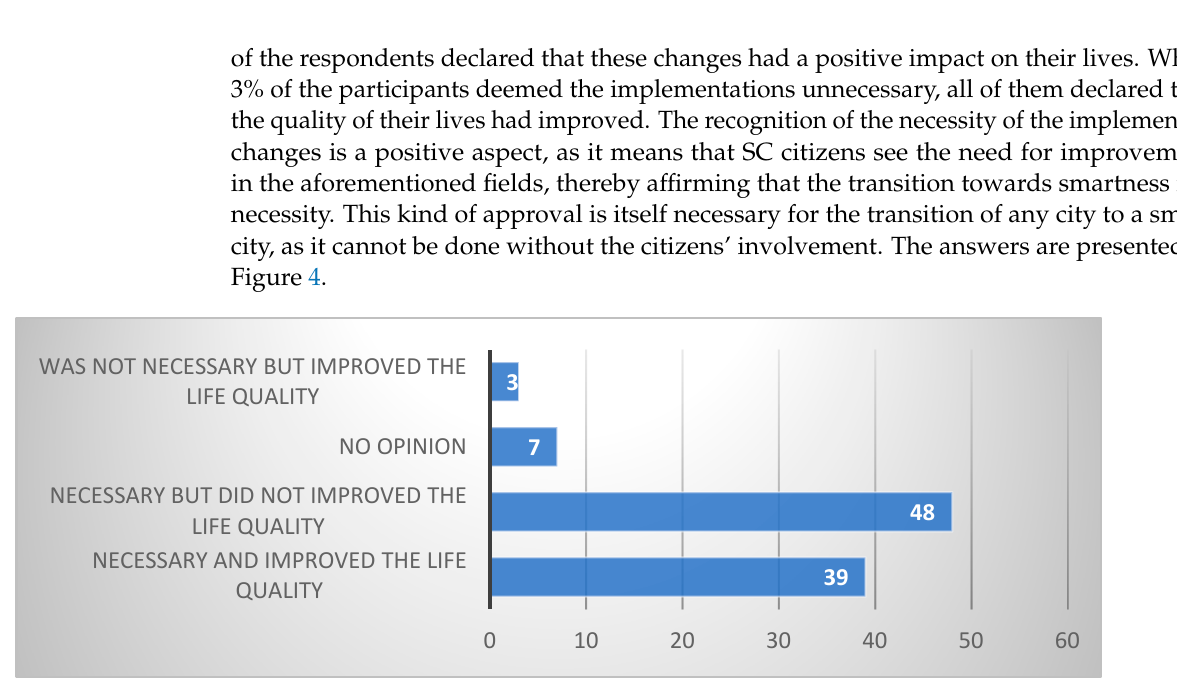
Figure 4. The respondents’ views (%) of smart projects implemented in their SCs. Source: own elaboration.